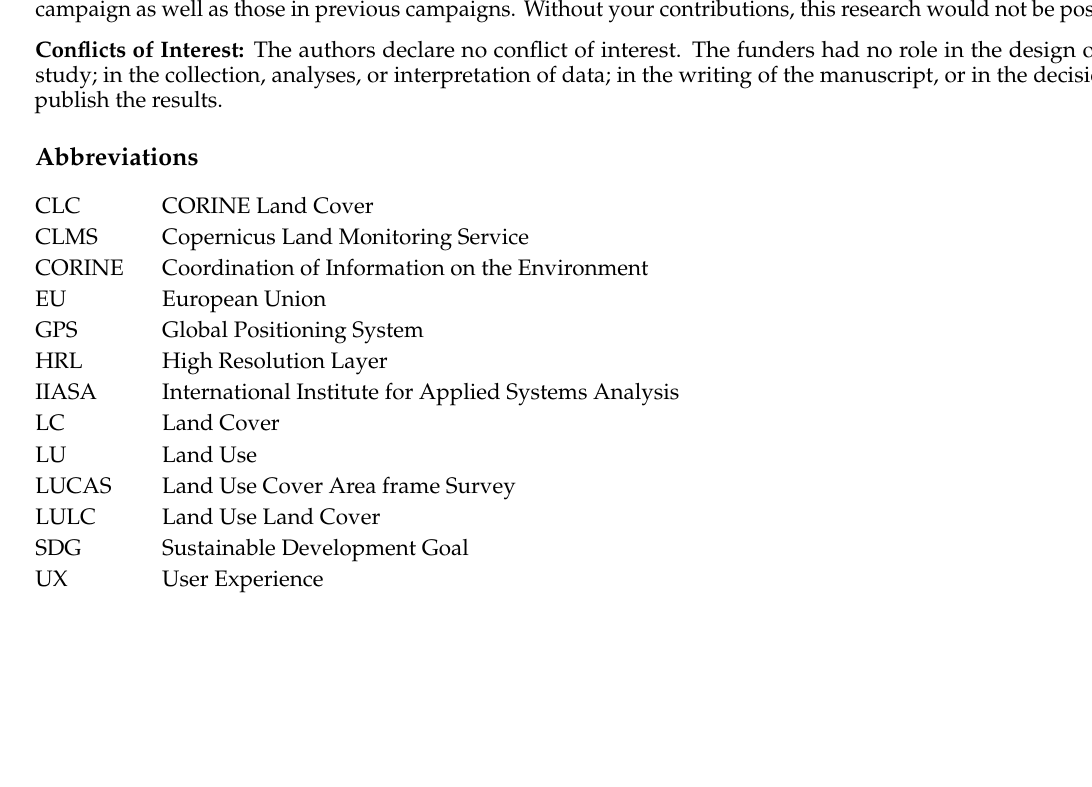
Table S1: LUCAS LC classes for levels 1, 2, and 3, Table S2: Types of feedback provided to the users from the near real-time quality assurance system, Table S3: Recommendations sent as feedback disaggregated by type of feedback, Table S4: Results from the survey regarding which features of the FotoQuest Go Europe 2018 campaign were liked by the users. An intense green color means a higher number of respondents, whereas pale blue colors represent the lowest number of respondents, Table S5: User-recommended improvements for future FotoQuest Go Europe campaigns. An intense green color means a higher number of respondents, whereas pale blue colors represent the lowest number of